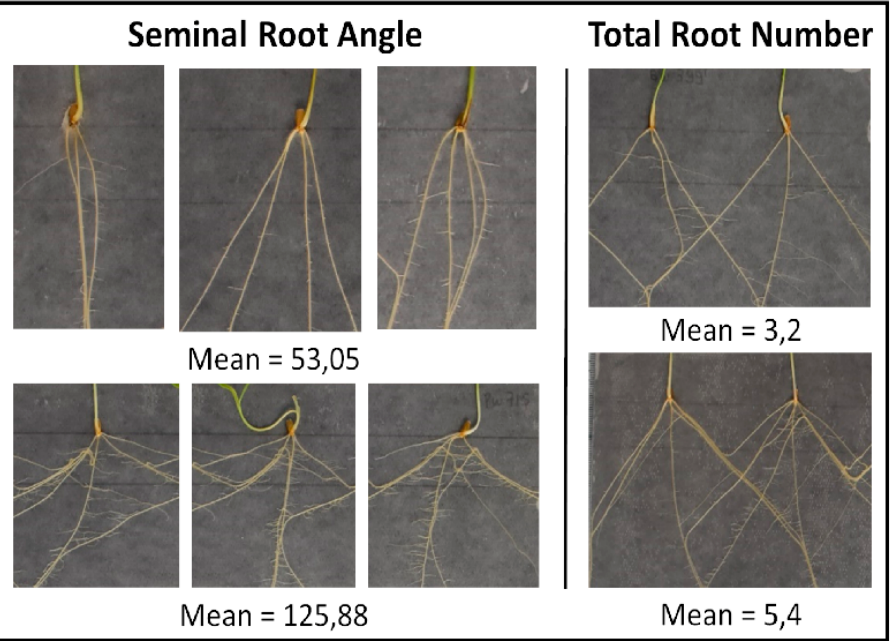
Figure 4. Extreme phenotypes for SRA and TRN. The means correspond for 3 observational units of the genotype for SRA and 5 observational units of the genotype for TRN.